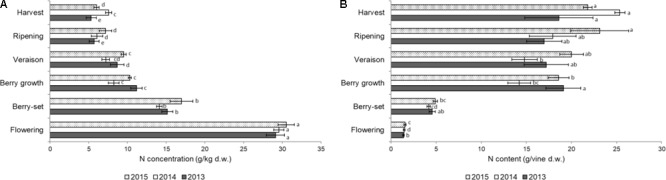
Nitrogen concentration (A) (g/kg of dry weight) and content (g per vine) (B) in the clusters of Italia table grape throughout the seasons of 2013, 2014, and 2015 as a function of the different phenological growth stages. Bars represent SD. For each season, data points followed by a different letter are significantly different at P ≤ 0.05 according to REGQW test. Kruskal-Wallis non-parametric test was used, followed by the Conover-Iman test at P ≤ 0.05, for heteroscedastic values.